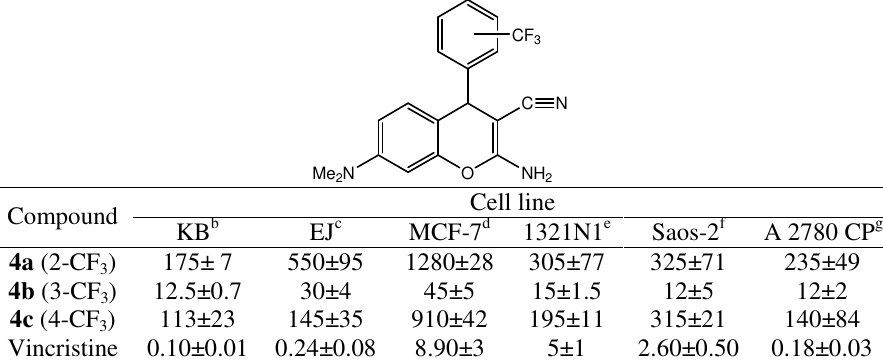
, nM) a of compounds ( 4a–c) against different cell lines in 50